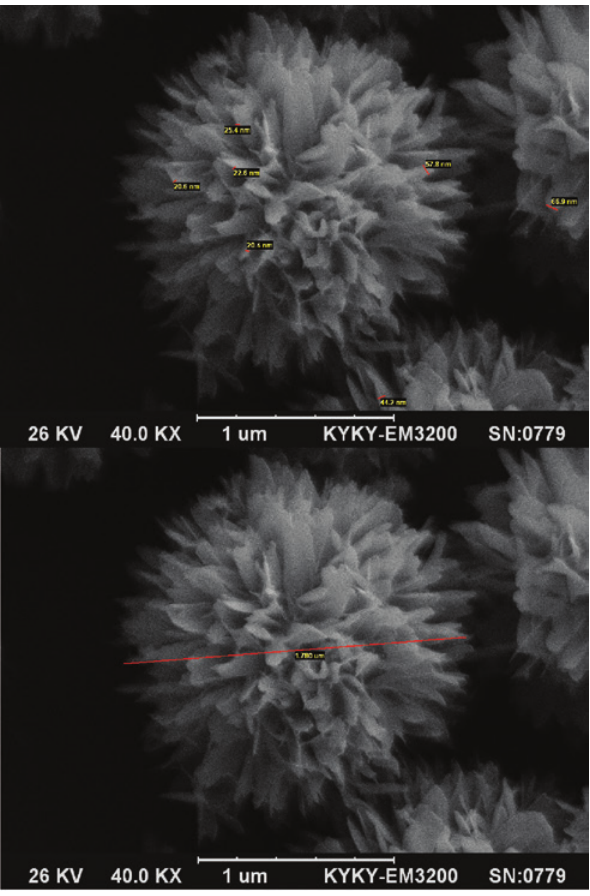
Figure 2: SEM images of PbS obtained in the presence of glucose (capping